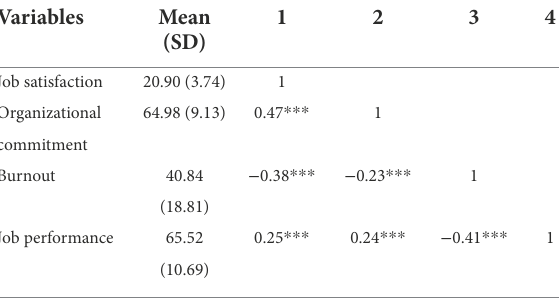
TABLE 3 Pearson’s correlation coefficients of key study variables.